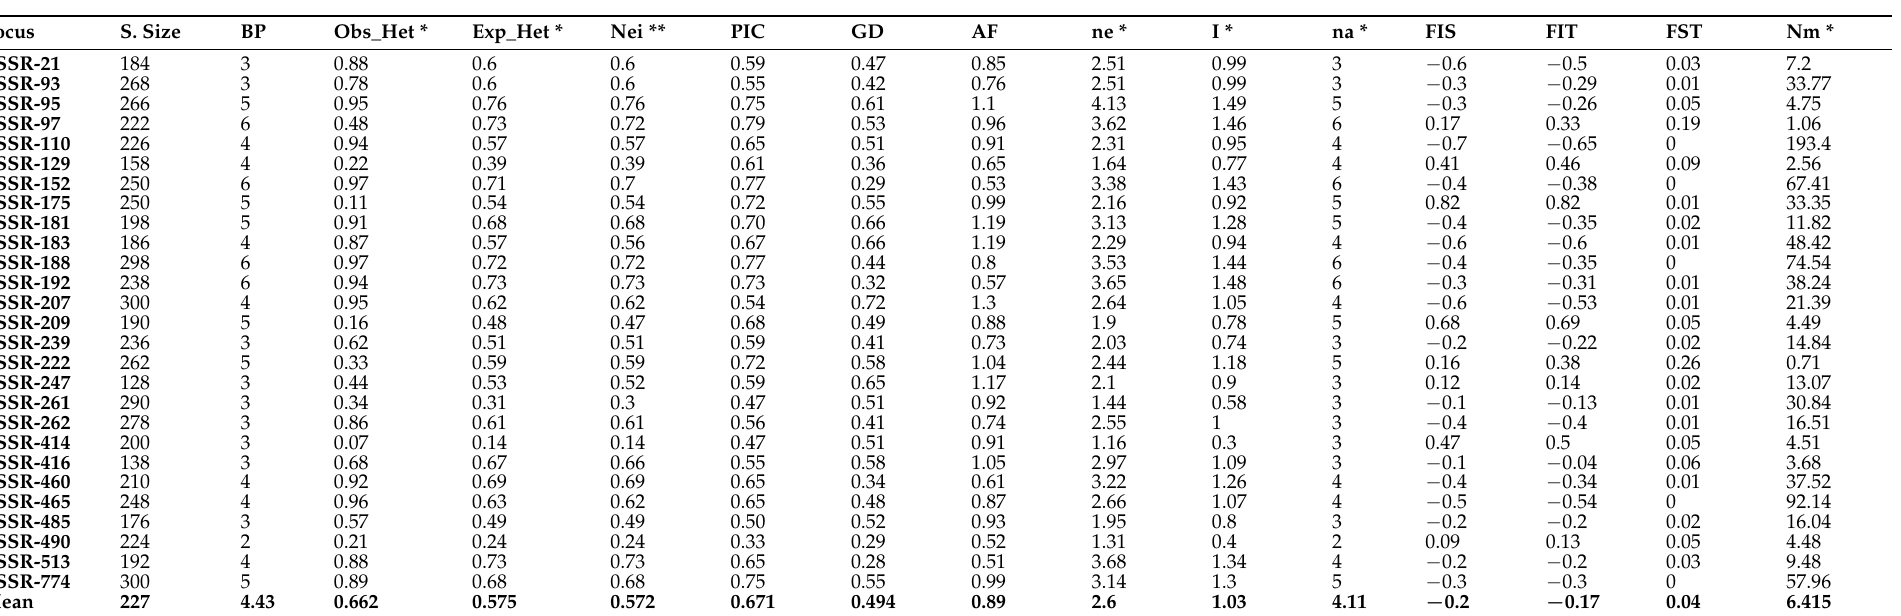
Table 4. Genetic variation analysis for 27 molecular SSRs markers studied among Ziziphus nummularia collected from different geographical regions of KP, Pakistan.